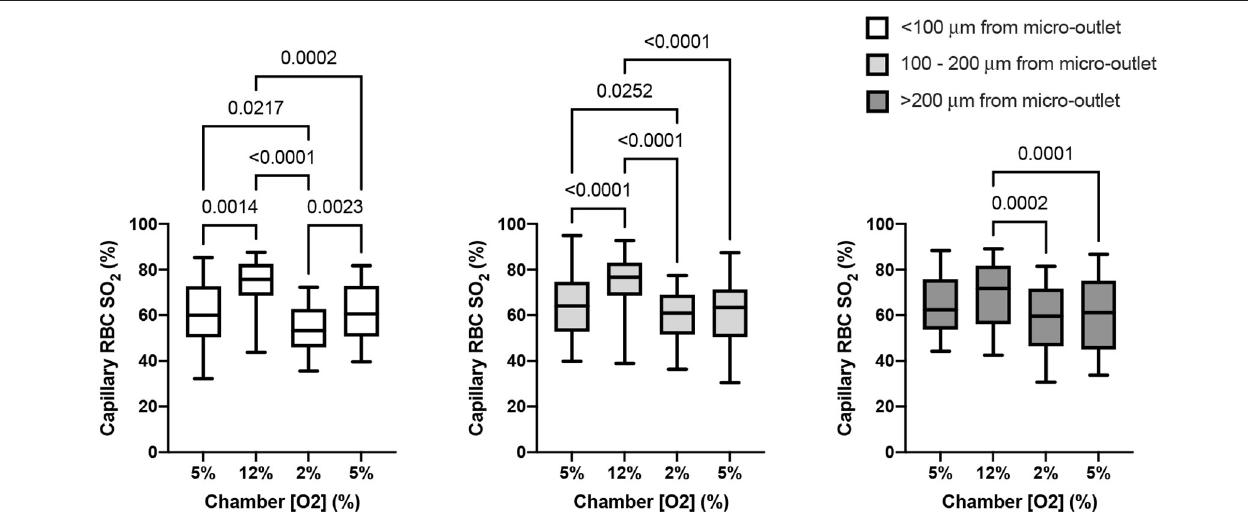
FIGURE 11 | Capillary oxygen saturation responses in capillaries at various distances from the exchange windows of the modular gas exchange platform. The platform imposed a square wave oxygen challenge from a baseline of 5% O 2 followed by 2 min of 12%, 2 min of 2%, and 1 min of 5% each with 5% CO 2 and balance N 2 . Each panel shows the capillary red blood cell (RBC) oxygen saturation (SO 2 ) in the last 30s of each imposed platform oxygen concentration across 14 fields in 4 animals. The left panel shows oxygen saturations in capillaries within < 100 µ m from the exchange window ( n = 17 capillaries). The middle panel shows mean capillary RBC SO 2 in vessels between 100 and 200 µ m from the window ( n = 27 capillaries), and the right panel shows responses in capillaries > 200 µ m from the edge of the exchange window ( n = 19 capillaries). With increasing distance the magnitude of the SO 2 change diminishes, though significant changes in SO 2 imposed by the low oxygen condition in the platform were detectable beyond 200 µ m. p values based on Tukey’s multiple comparisons test after significant repeated measures ANOVA are indicated in the figure with a p < 0.05 considered to be significant. Box and whisker plots show minimum, median, maximum, and associated